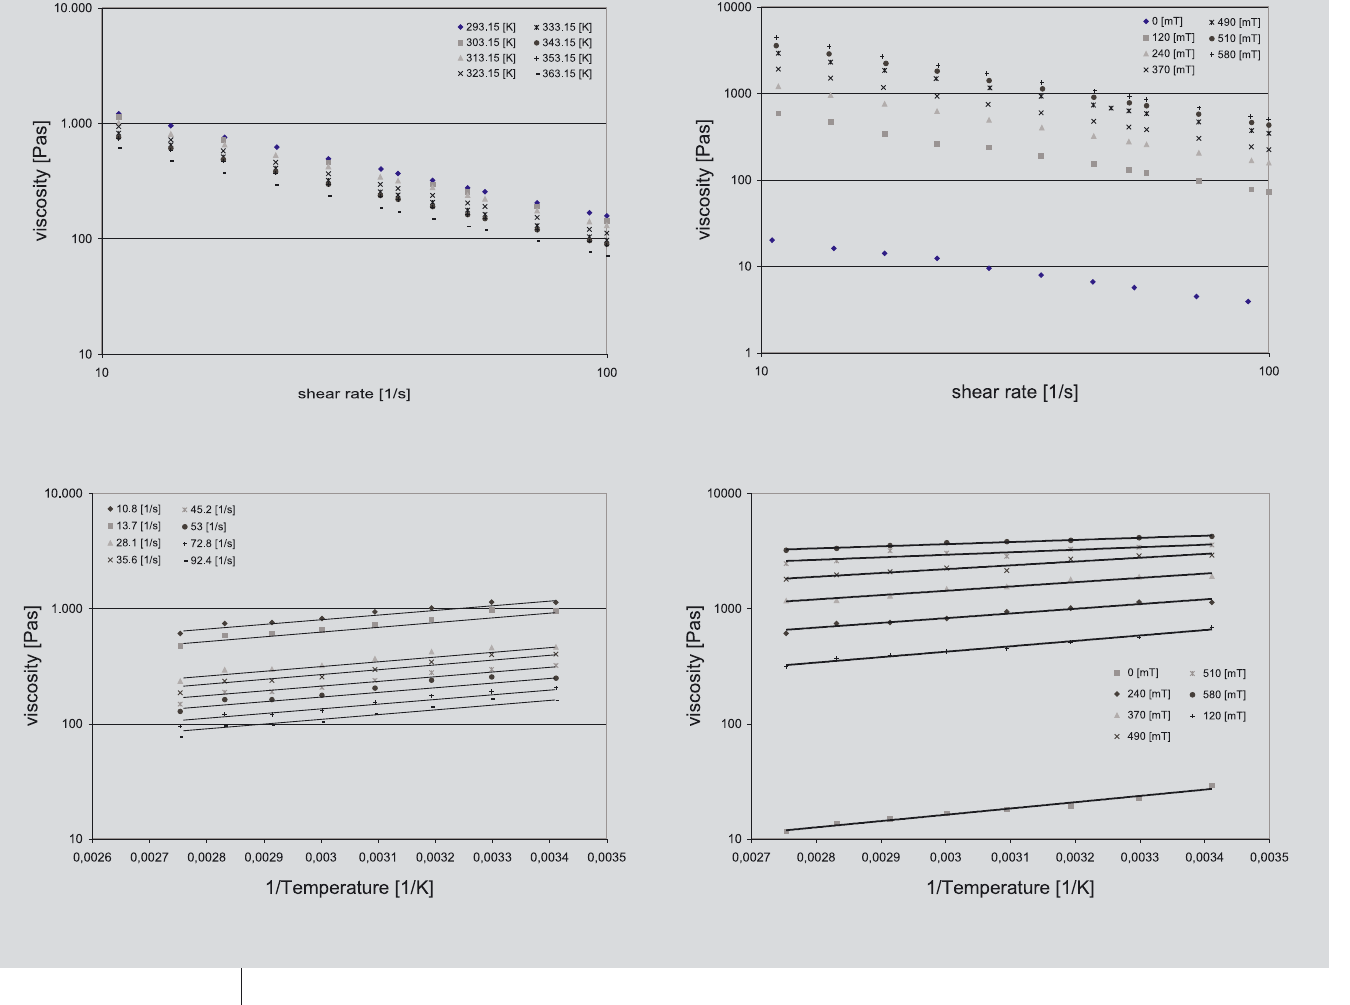
Figure 3 (left above): Viscosi- ty functions of isothermal measurements at 0.24 T. Figure 4 (right above): Viscosity functions at 293.15 K at different magnetic field strengths. Figure 5 (left below): Arrhe- nius plot of log h versus 1/T for MRF 132 AD at 0,24 T for different shear rates Figure 6 (right below): Arrhenius plot of log h versus 1/T for MRF 132 AD at 10.8 s -1 for different magnetic